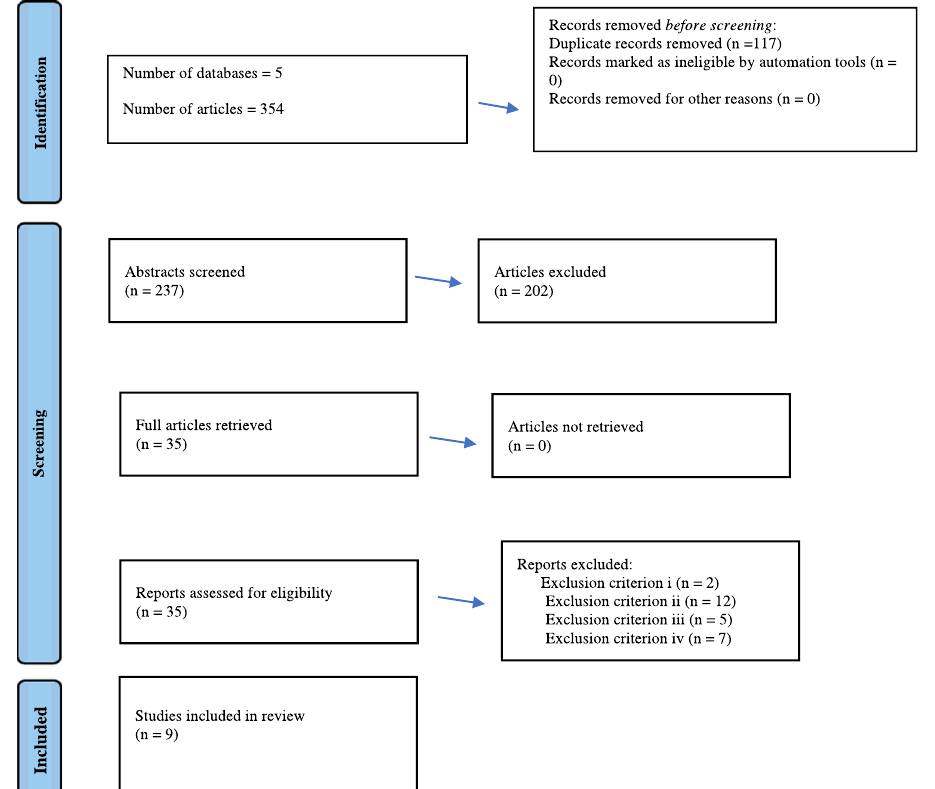
Fig. 2 Schematic representation of the shortlisting process (adaptation of the 2020 PRISMA guidelines for reviews). The sequential reduction in the number of articles is shown in descending order. Since there are overlapping search fi elds in the different databases, a large proportion of the total number of papers were redundant, leading to the removal of duplicates. The authors read the article titles to determine which abstracts were appropriate for reading. The relevancy of the abstracts was used to locate candidate articles for full reading, with the exclusion criteria being applied to these candidates to arrive at a fi nal selection of